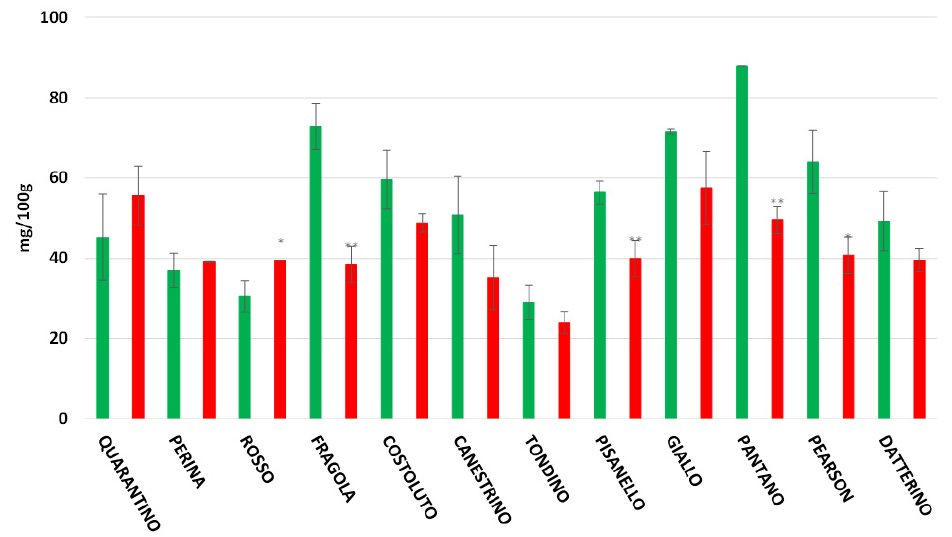
Figure 9. Vitamin C (ascorbic acid) content in tomato peel of 9 Italian cultivars and three commercial cultivars. Controls (CTRL) in green and drought-stressed group (DS) in red. The bars indicate the standard deviation. A significantly difference is shown between CTRL and DS of each cultivar by * for a p ≤ 0.05 and ** for p ≤ 0.01.